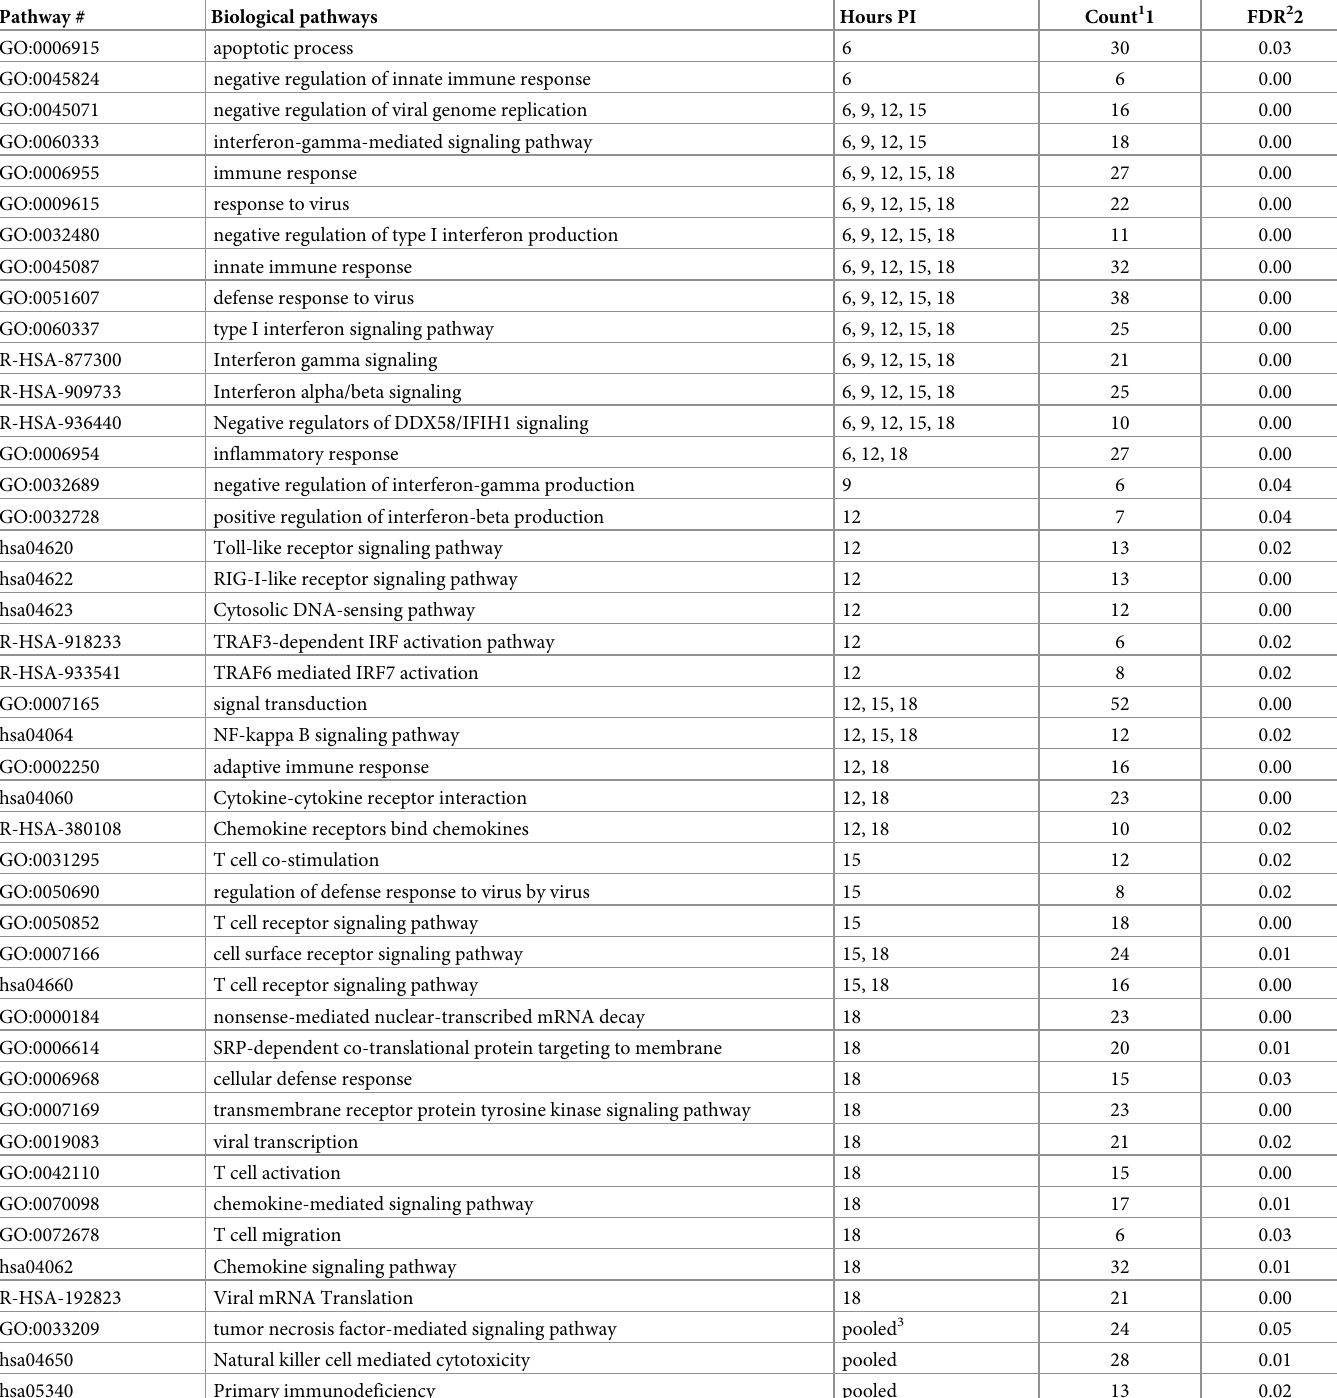
Table 2. Immune-related biological pathways with over-represented genes of 1481 significantly up-regulated genes using a web tool (DAVID Bioinformatics Resources 6.8) during the first 18 hours of infection. Pathway